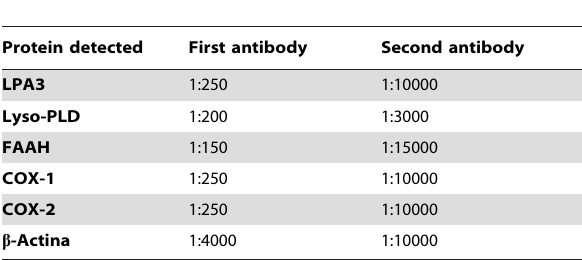
Table 2. First and the second antibody dilutions employed in Western Blot